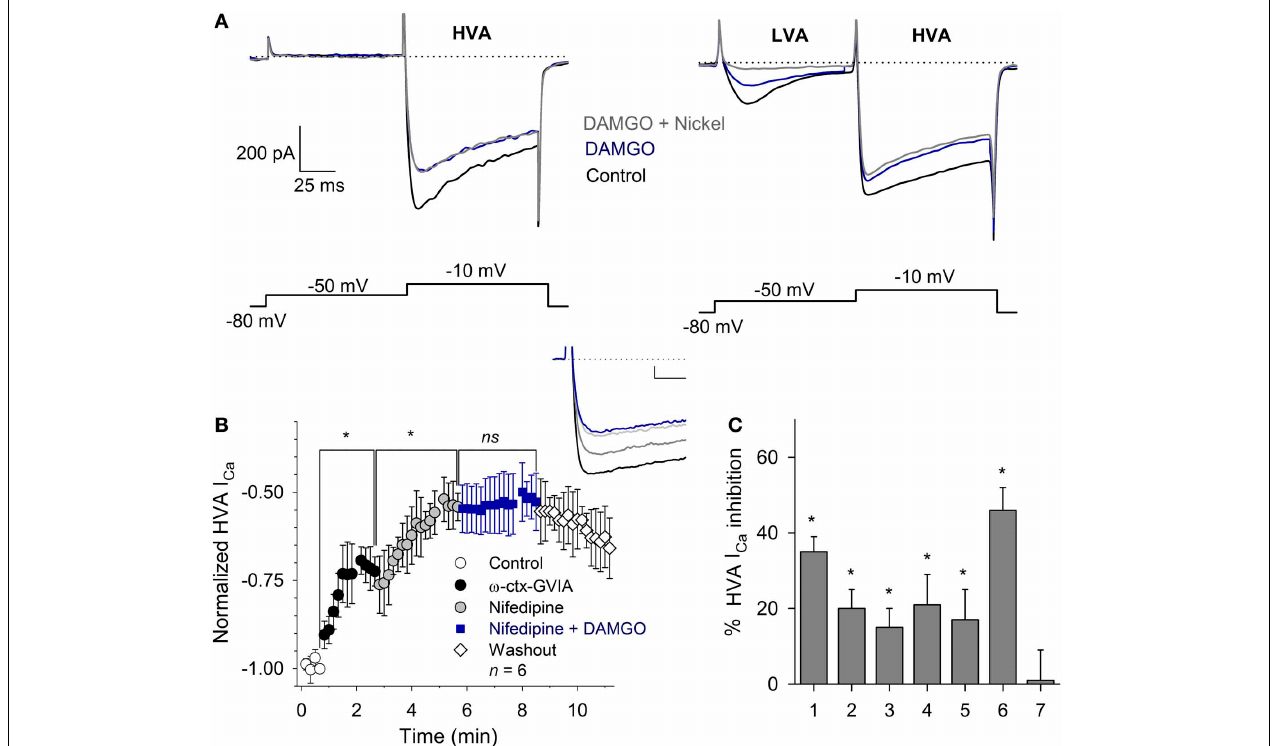
FIGURE 4 | Calcium current modulation by MOR activation. (A) Representative traces of the I Ca in neurons with (right) and without (left) LVA current. Two-pulse voltage protocol (shown below) evidenced the LVA and HVA currents. Use of 1 μ M DAMGO inhibited both I Ca components. Nickel (100 μ M) blocked the LVA current without affecting the HVA component. The dotted line represents zero current. (B) Time course of the HVA current in the control and after the application of 3 μ M ω -ctx-GVIA, followed by 10 μ M nifedipine and nifedipine plus 1 μ M DAMGO ( n = 6; ns, non-significant; ∗ P ≥ 0 . 5). The application of ω -ctx-GVIA and